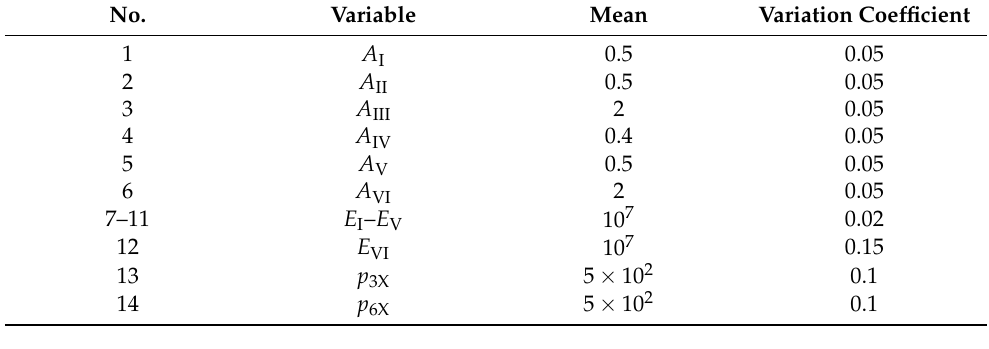
Table 5. Input variables for the truss structure.